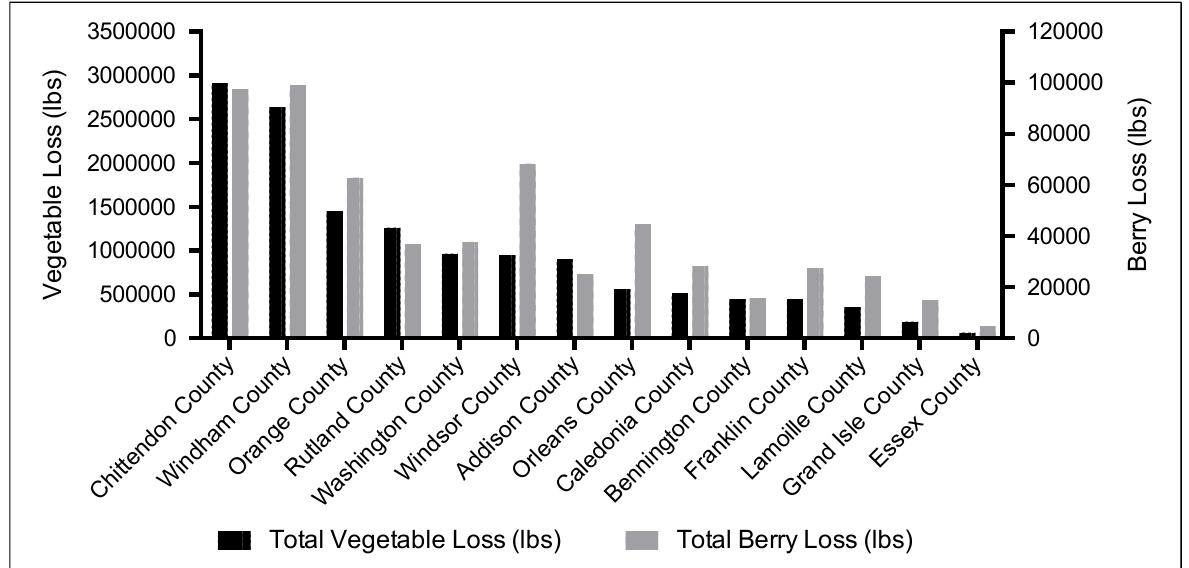
Figure 5. Vegetable and Berry Loss by Vermont County, Modeled Based on 2016 Survey and County Acres